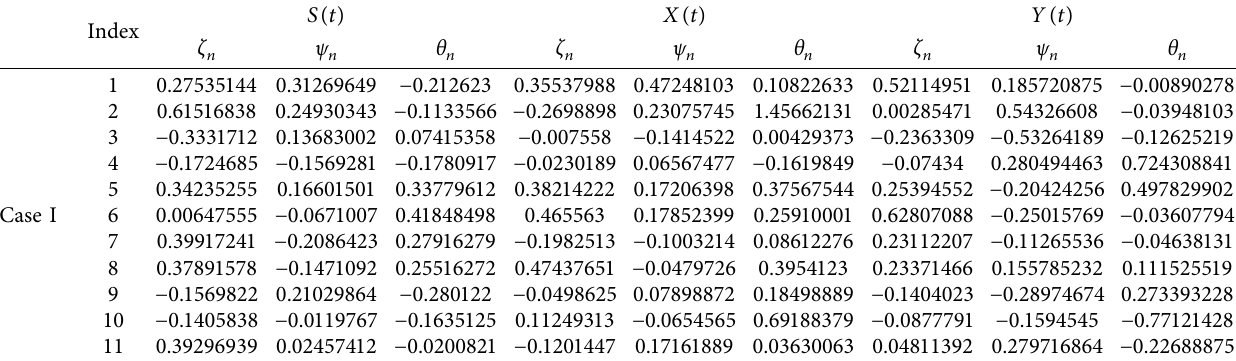
Table 32: Unknown parameters obtained by the LeNN-WOA-NM algorithm for the prey-predator model under the influence of variations in β 2